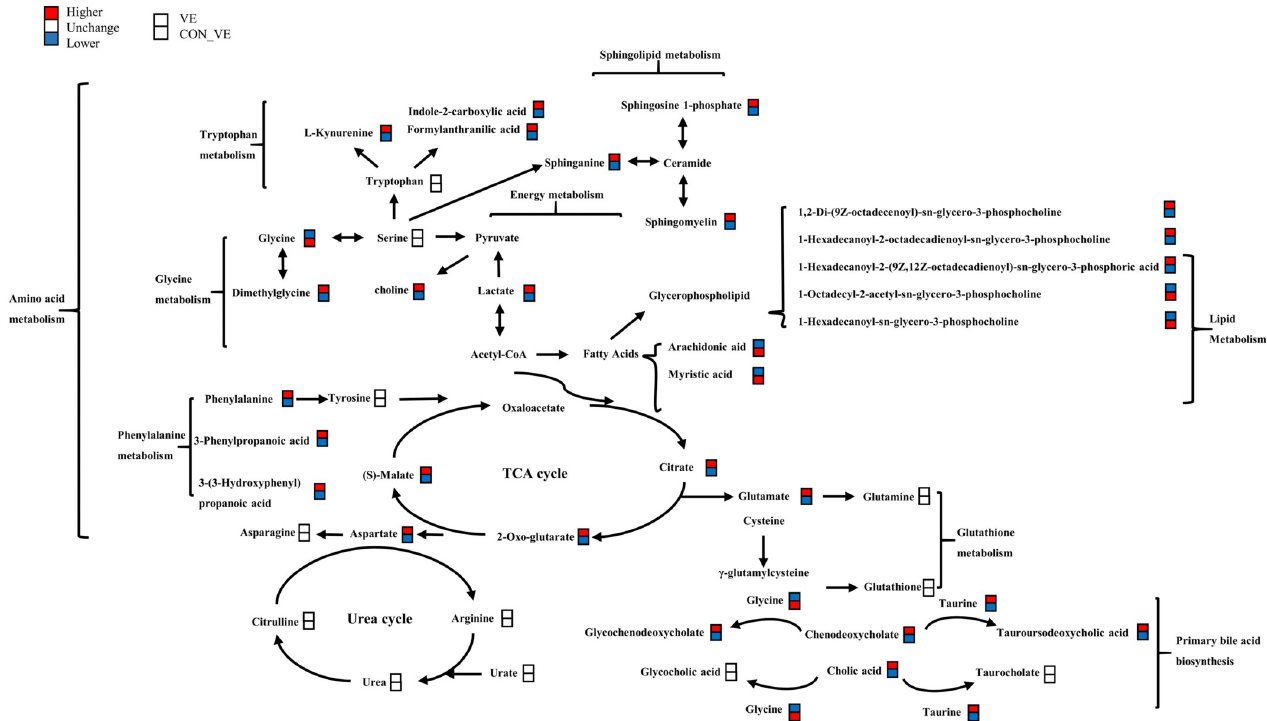
Fig 7. Metabolic network in yak serum induced before and after VE injection. The red boxes represents the higher concentration of metabolites and the blue boxes represents the low.